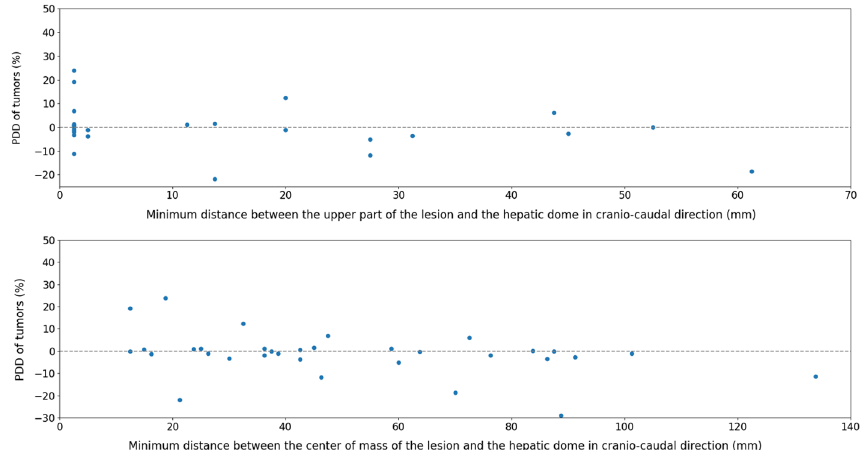
Fig. 10 Percentages of tumor dose difference according to the minimum distance between the upper part of the lesion and the hepatic dome in cranio‑caudal direction (top) and the minimum distance between the center of mass of the lesion and the hepatic dome in cranio‑caudal direction